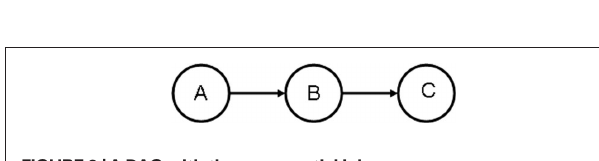
FiGure 3 | A DAG with three sequential jobs.